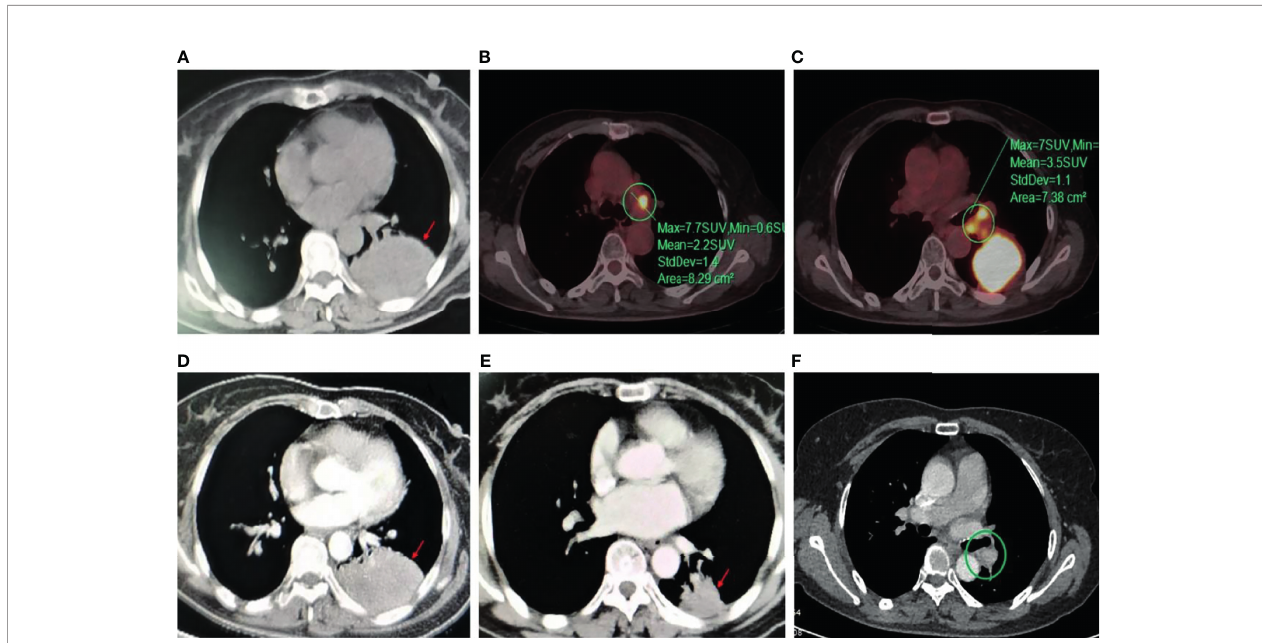
FIGURE 3 | Disease status before and after neoadjuvant chemotherapy and aumolertinib treatment. Computed tomography chest (CT) scan showed that (A) before chemotherapy, the size of the left lower lung soft tissue mass was 10.9 × 8.9 × 6.5 cm. PET/CT showed (B) mediastinal lymph node enlargement before chemotherapy. (C) Multiple lymph node enlargement in the left hilar before chemotherapy. CT scan showed that (D) after 2 cycles of chemotherapy, the disease was judged to be stable based on imaging fi ndings. (E) After 2 cycles of aumolertinib treatment, the size of the left lower lung soft tissue mass was 3.0 × 4.0 × 4.0 cm, and the tumor achieved partial remission. (F) After 2 cycles of aumolertinib treatment, multiple lymph nodes disappeared in the left